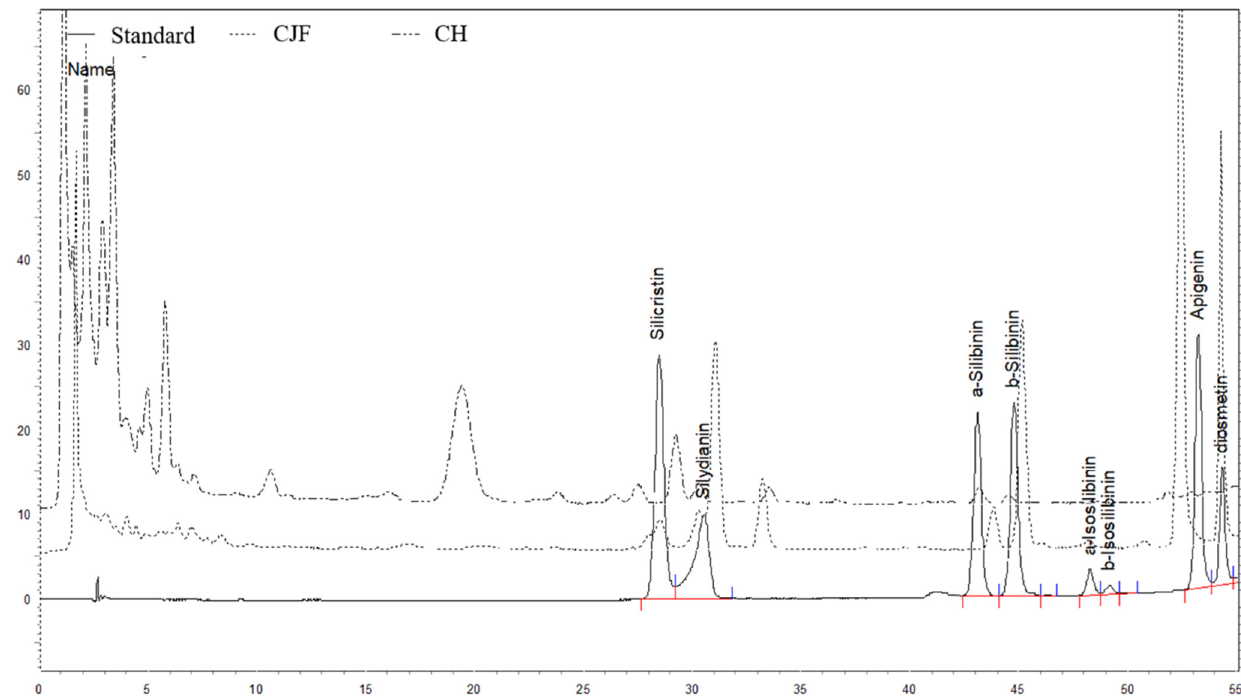
Figure 2. High-performance liquid chromatography (HPLC) chromatogram of standards, the methanolic standardized extracts of CJF, and Cirsii Herb at 280 nm. CJF, the flower part of C. japonicum DC. var. australe ; CH, Cirsii Herb.